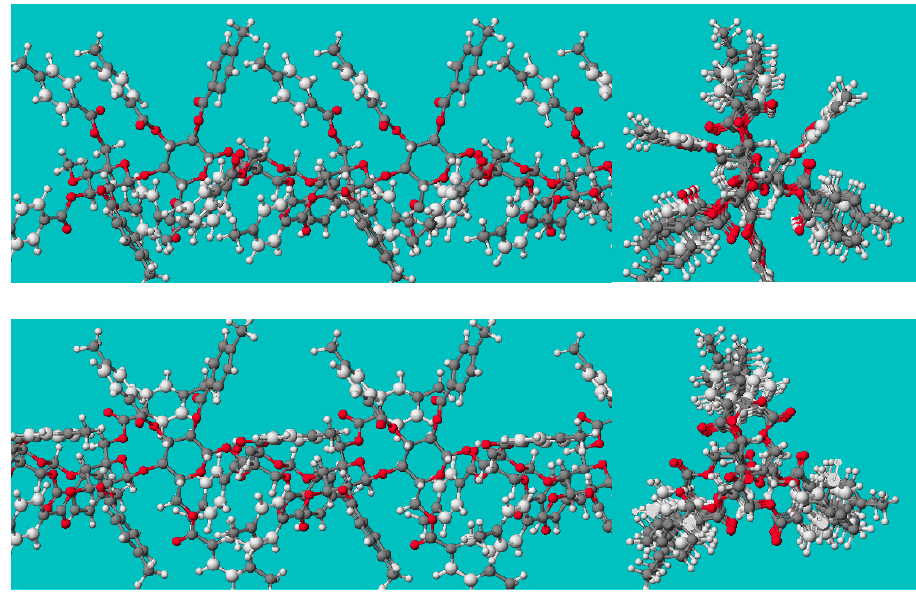
Figure 3. Two predicted conformers of cellulose tris(4-methylbenzoate) [23]. Upper : The bonds O(5)–C(6) and C(6)–O(6) taking gauche conformation, and C(5)–C(4) vs. C(6)–O(6) is gauche too (gg-conformer). Lower : The former taking gauche conformation and the latter taking trans conformations ( gt -conformer).